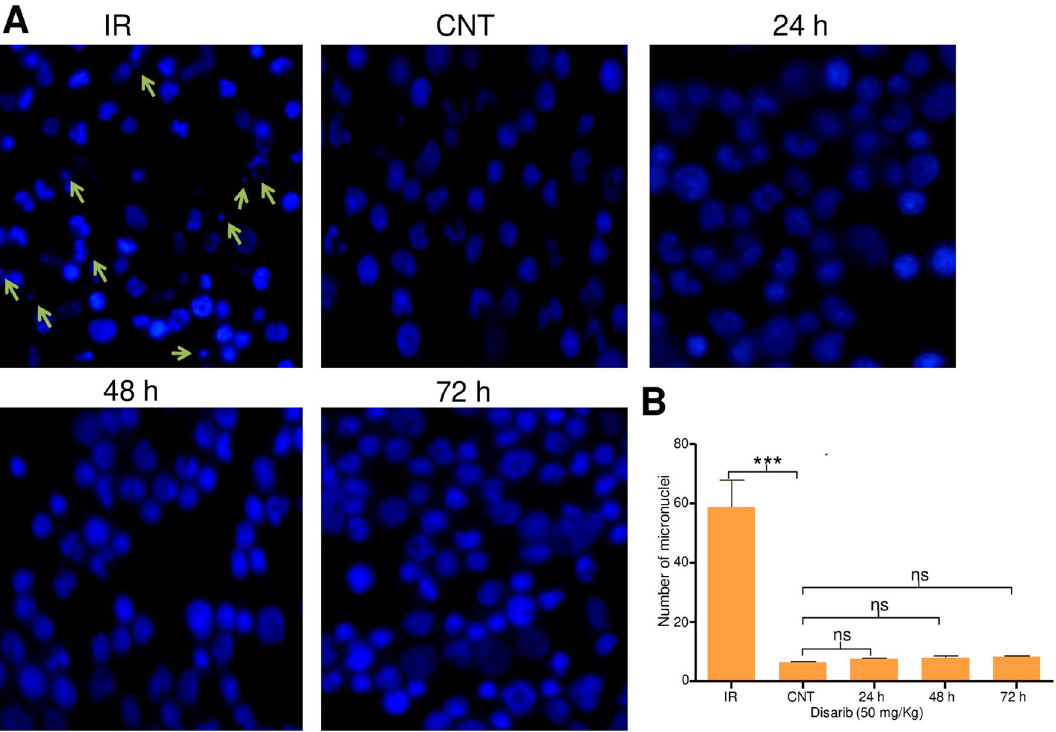
Figure 8. Micronucleus assay to evaluate genotoxicity of Disarib. ( A ) Representative image of vehicle control- treated and Disarib treated (24, 48 and 72 h) bone marrow cells (at 100 ×) after staining the nucleus with DAPI. In each case rats were treated with Disarib (50 mg/kg). 4 Gy IR irradiated cells served as positive control. ( B ) Bar diagram showing quantitation of micronucleus present in bone marrow cells of vehicle control (CNT), and Disarib treated animals (24, 48 and 72 h). Positive control, irradiated samples (4 Gy) were also quantitated and presented. Two animals at each time point were analyzed, and 500 cells per animal were counted for the analysis. Error bars denote mean + SEM ( ns not significant, ***p <